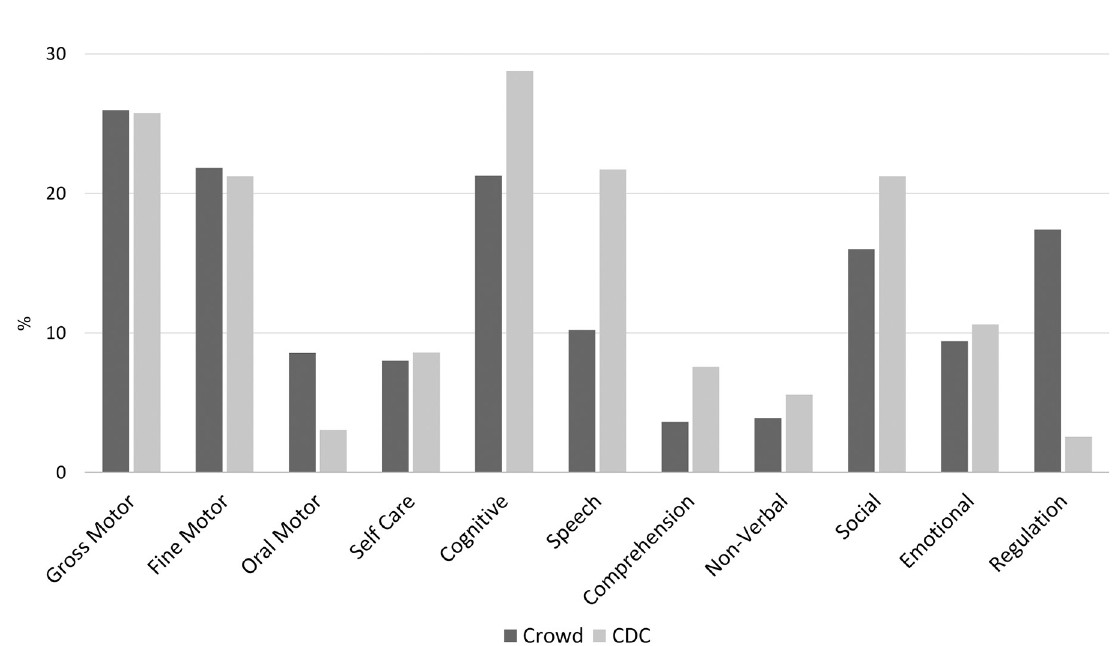
Fig 4. Percentage of milestones per domain within CDC versus crowd-based milestones.